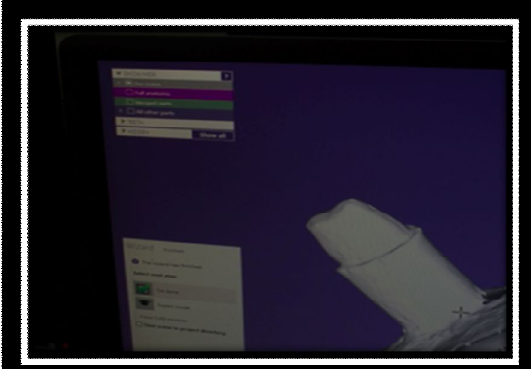
Figure 5: Full 3D scan of master die in monitor.